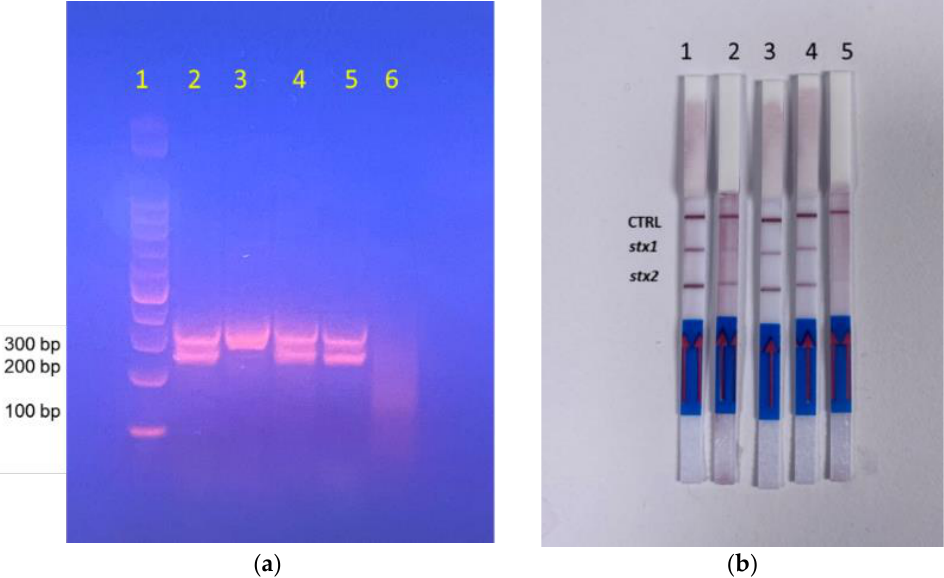
Figure 7. ( a ) 2% agarose gel visualization of the following: 1. DNA marker, 2: 10 6 E. coli O157:H7, 3: 10 6 E. coli O26, 4: 10 6 E. coli O121, 5: all three strains mixed at a concentration of 10 4 CFU/mL, 6: negative control.; ( b ) Lateral flow assay visualization of the same RPA products. 1: E. coli O157:H7, 2: E. coli O121, 3: E. coli O26, 4: Mixed sample, 5: Negative control. These experiments were repeated at minimum of 3 separate times on different days to ensure reproducibility. A representative image is shown.